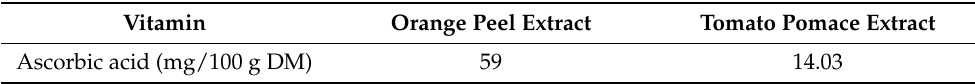
Table 2. Ascorbic acid content of orange peel and tomato pomace extracts. Vitamin Orange Peel